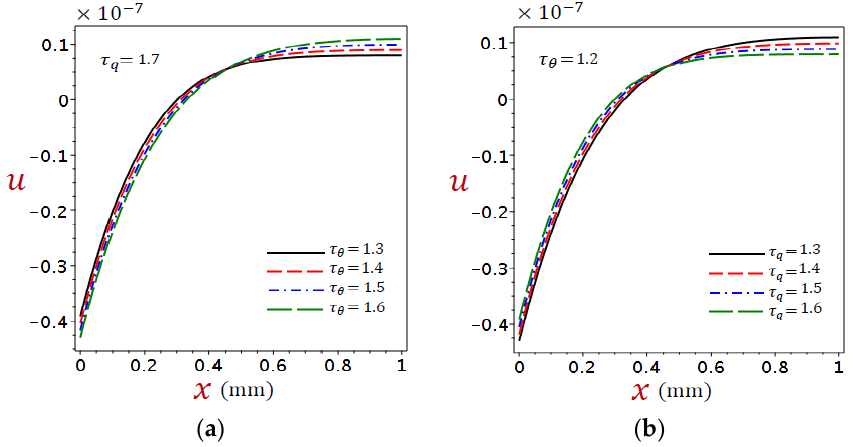
Figure 11. Distributions of displacement ( u ) for refined DPL model under ( a ) different τ θ with τ q = 1.7 and ( b ) different τ q with τ θ = 1.2.